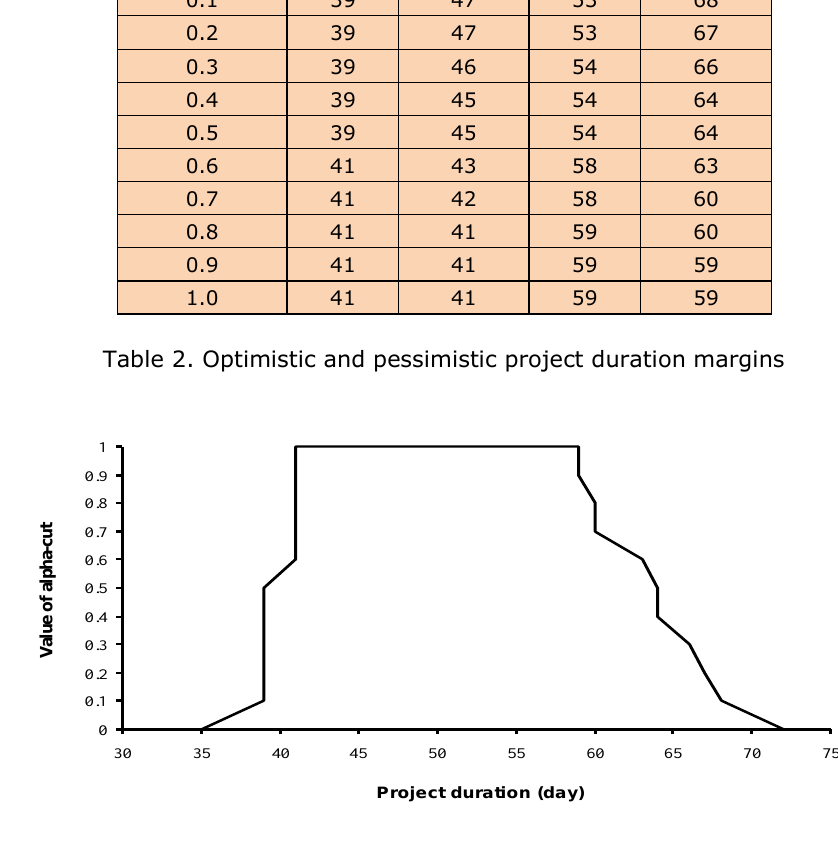
Figure 7. Possible project duration spectrums of the